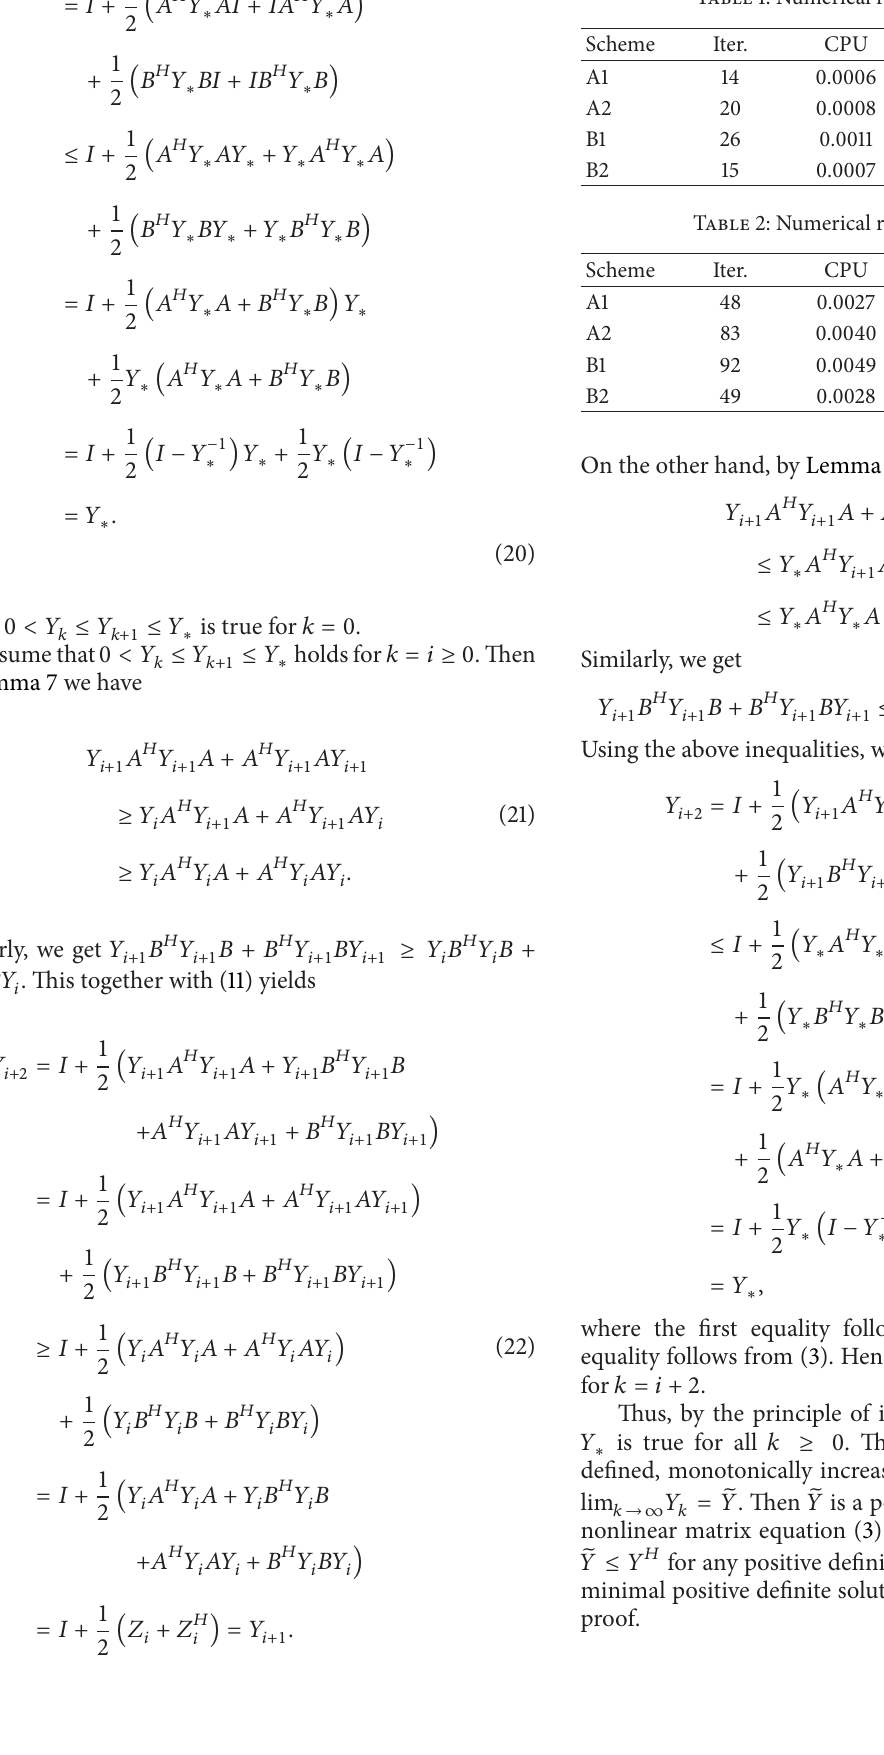
Table 1: Numerical results of Example 11.